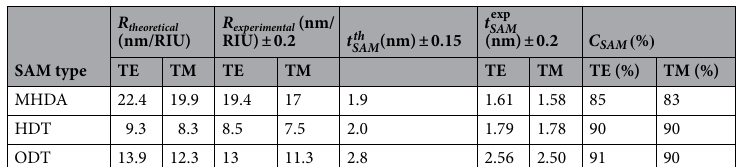
Table 2. Theoretical and experimental comparison of the SPR response (Eq. 4), SAM thickness (Eq. 5) and coverage (Eq. 6) for TE and TM polarisation. Note that the theoretical SAM thickness, t chain length (see Table